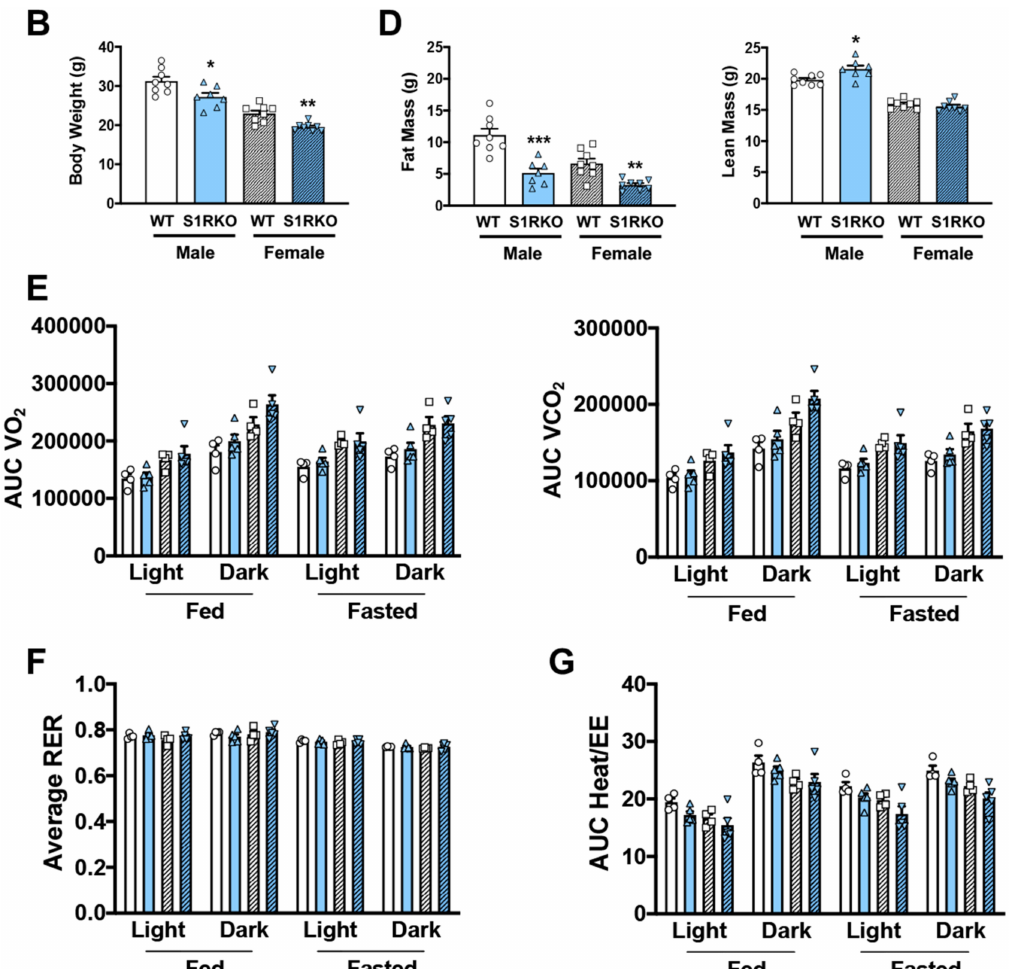
Figure 1. S1R ablation reduces body-fat mass and increases lean mass in HFD-fed male and female mice. All measurements were performed after 6 weeks of HFD. ( A ). Legends for ( B – G ). S1R WT: Sigmar1+/+ . S1R KO: Sigmar1 − / − . ( B ). Body weight. ( C ). Body composition (% mass vs. total mass). ( D ). Body composition (mass in grams). ( E ). Metabolism. Data were normalized to body weight. ( F ). Respiratory exchange ratio (RER). ( G ). Heat/EE (energy expenditure). Data were normalized to body weight. Each dot (data point, please see the circle, triangle, and square symbols) on the plots represents the area under the curve (AUC) or average (for RER) of each 12-h time period for each individual animal. Statistical analysis: One-way ( B – D ) or two-way ( E – G ) ANOVA with Bonferroni’s multiple comparisons test (* p < 0.05, ** p < 0.01, *** p < 0.001), S1R KO vs. WT, n = 7 or 8 mice in ( B – D ) or n = 4 or 5 mice in ( E – G ). Data are presented as means ±